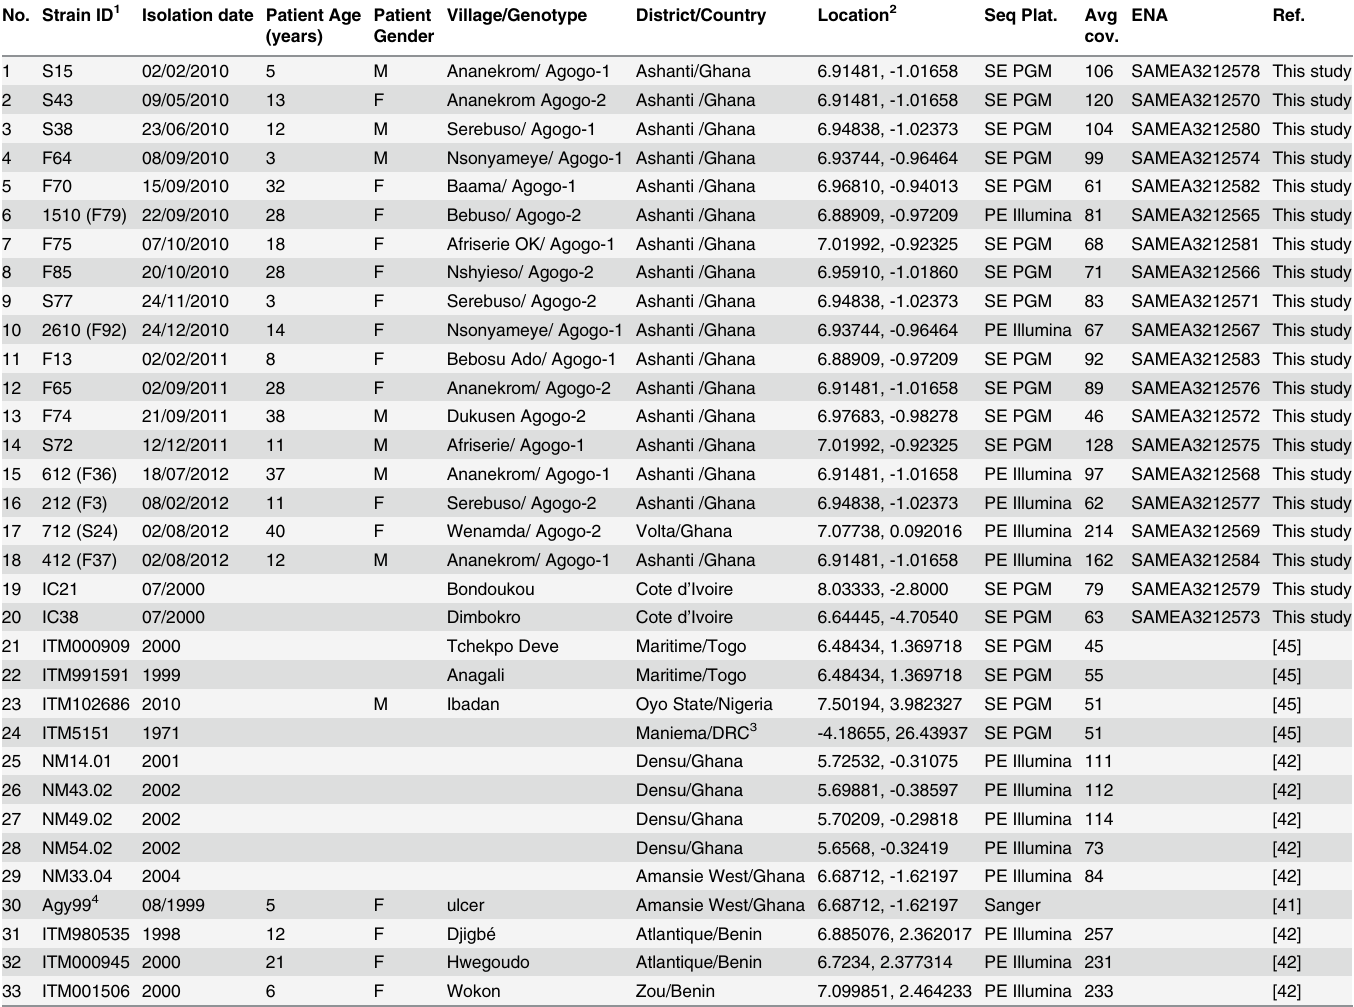
Table 1. M . ulcerans isolate and DNA sequencing